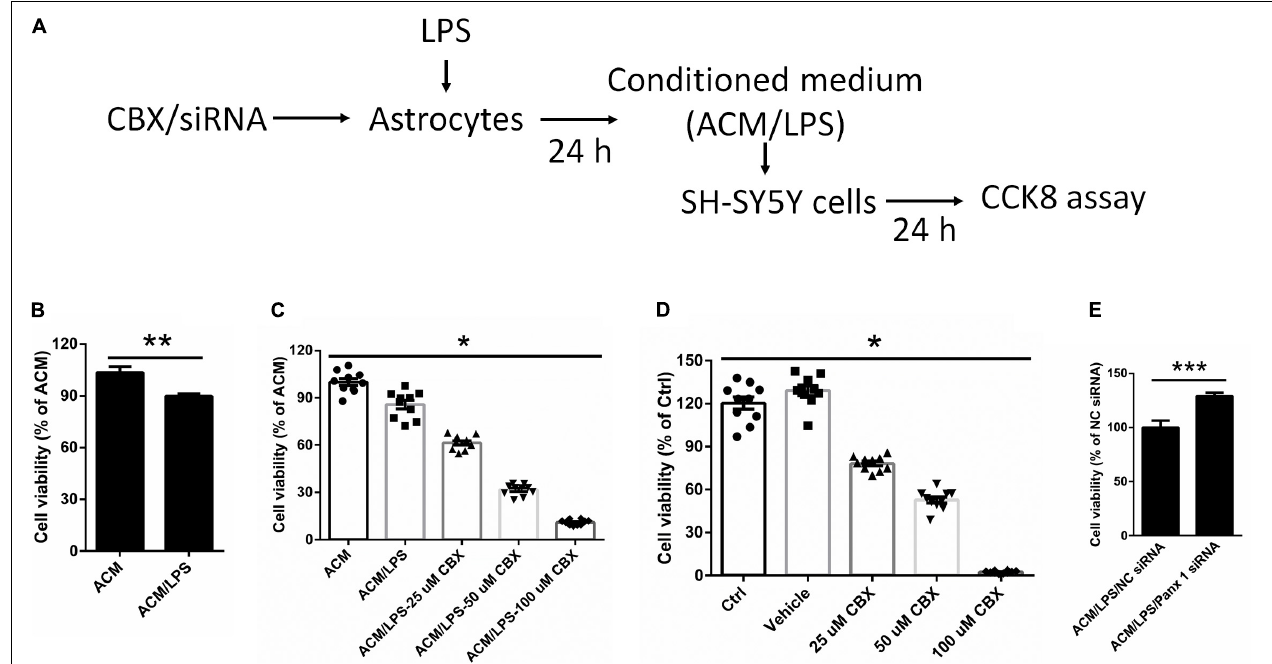
FIGURE 7 | Effect of different conditioned medium on the viability of SY-SY5Y cells. (A) Illustration of the experimental design. After treatment with CBX or siRNA, astrocytes were incubated with 100 ng/ml LPS for 24 h. The medium we collected as ACM/LPS were added into SH-SY5Y cells for 24 h and CCK 8 assay was performed to estimate cell viability. (B) Impact of ACM/LPS on the viability of SH-SY5Y cells compared with the group of astrocyte conditioned medium + LPS per se (without treating astrocytes). (C) SH-SY5Y cell viability was assayed by CCK8 assay under different conditioned medium, which from cells pretreated with CBX at different doses before incubation with LPS in astrocytes. (D) SH-SY5Y cells were treated with CBX alone at different doses and the viability was measured by CCK8 assay. (E) The medium from astrocytes treated with Panx 1 siRNA + LPS were added into SH-SY5Y cells and cell viability was assayed by CCK8 assay. The data were normalized to ACM group levels (ACM + LPS per se ), n = 3. All data are mean ± SEM. Statistical comparison for (C,D) were performed using one-way ANOVA, following by Newman–Keuls Multiple Comparison Test, and for (B,E) using Student’s t -test. * p < 0.05, ** p < 0.01, *** p < 0.001 compared with ACM